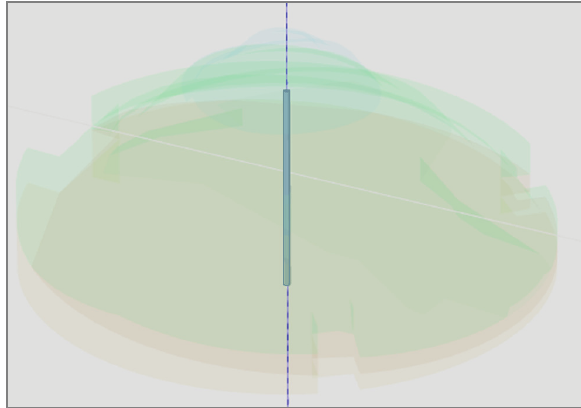
Fig. 5. Central drainage of the upper part of the mound